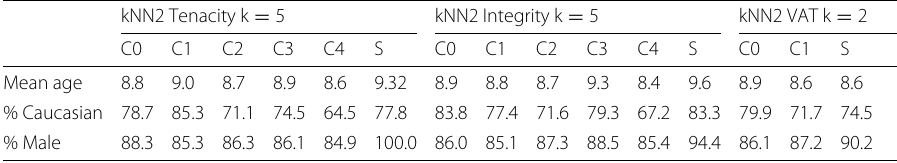
Table 5 Demographics per cluster configuration without node reassignment kNN2 Tenacity k =